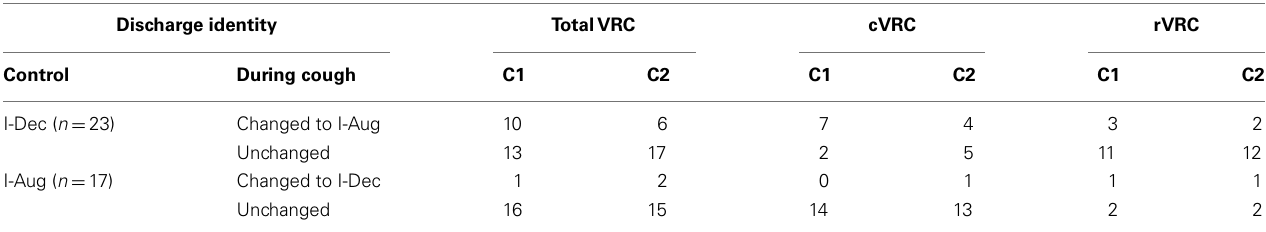
Table 2 |Average discharge identities of I-Dec and I-AugVRC neurons during the control period and the first two cough cycles in a multiple-cough response to intra-tracheal